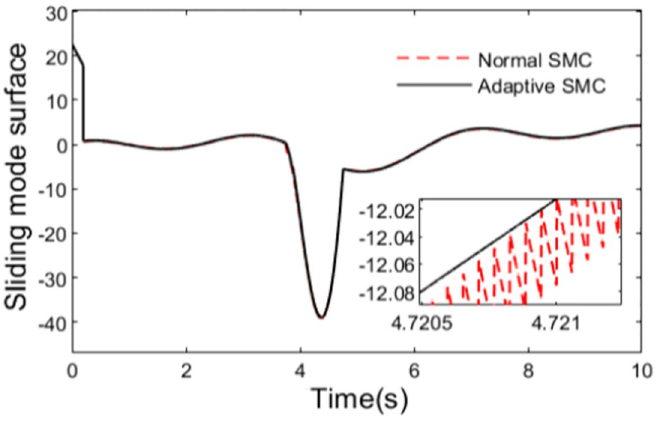
Fig 5. Sliding mode